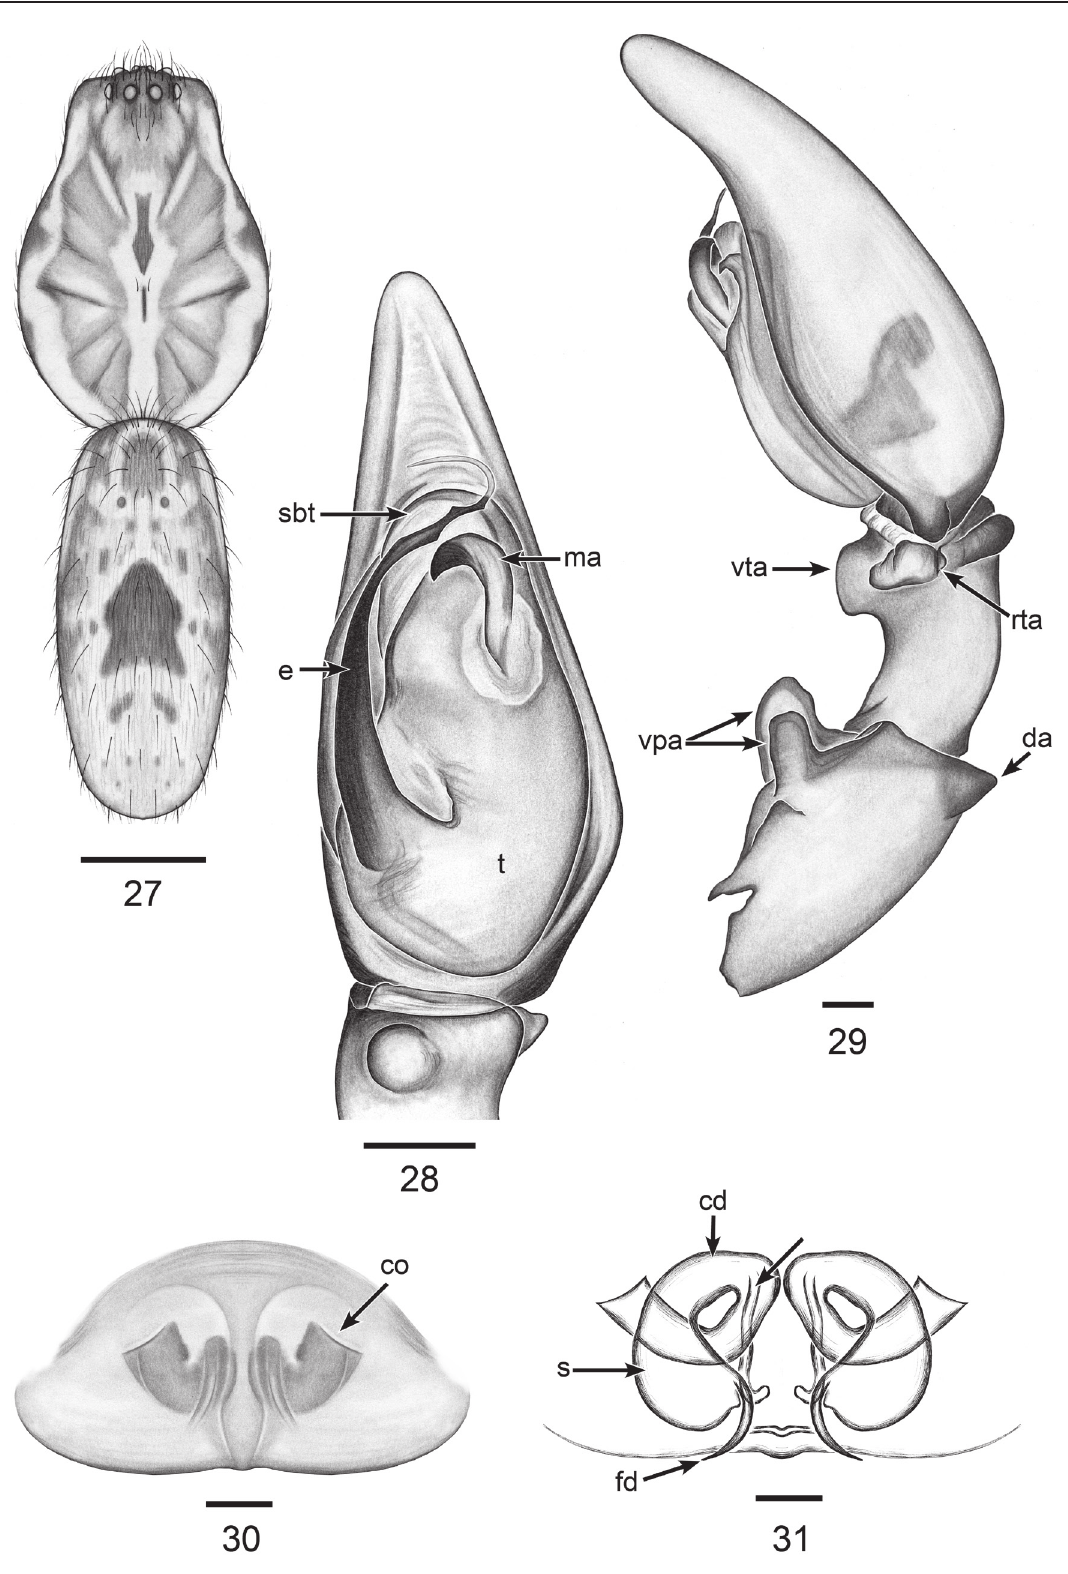
Figs 27–31. Shuyushka wachi gen. et sp. nov. 27 . ♂, habitus, dorsal view. 28 . ♂, palp, ventral view. 29 . ♂, palp, retrolateral view. 30 . ♀, epigynum, ventral view. 31 . ♀, internal genitalia, dorsal view. Scale bars: 28–31 = 0.1 mm; 27 = 1